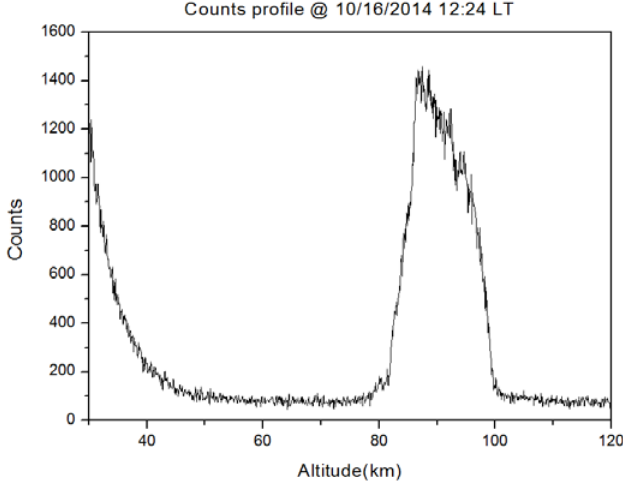
Figure 6. Original back-scattered photo data observed by sodium lidar during the daytime.